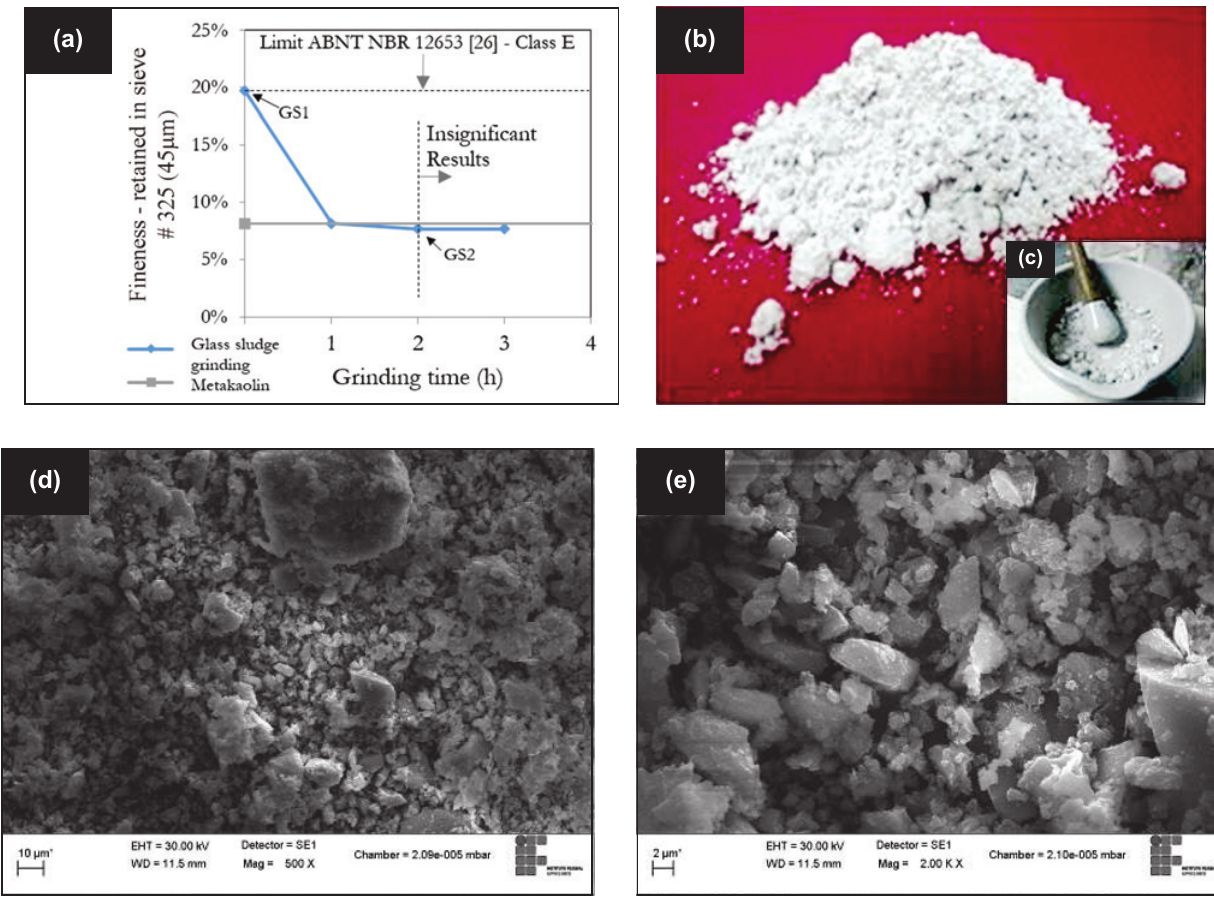
(a) Waste grinding time study; (b) GS2 (ground sludge), (c) GS1 (without grinding), (d) GS2 micrograph 500x; and (e) GS2 micrograph